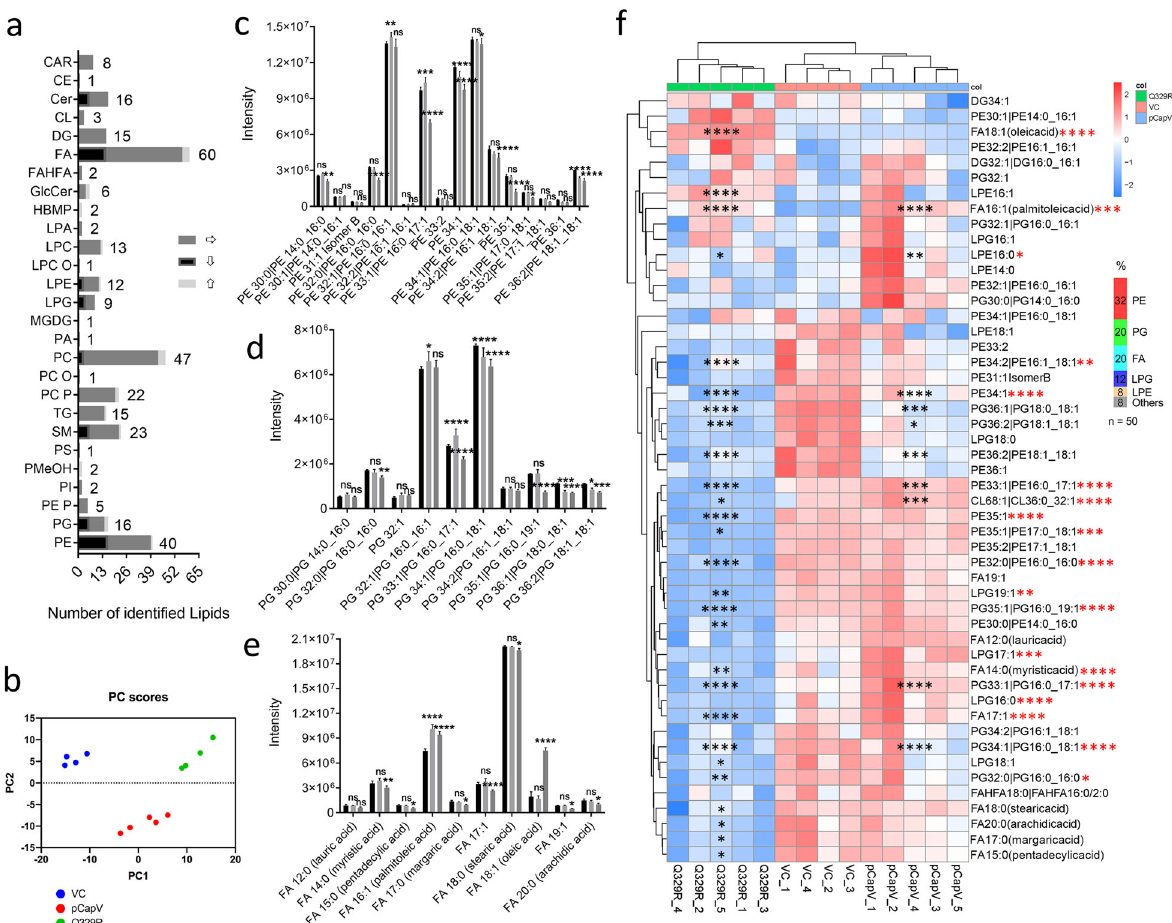
Fig. 4 CapV and CapV Q329R overexpression alter the steady-state lipid pro fi le of E. coli MG1655. a The number of identi fi ed lipid species in CapV and CapV Q329R induced fi lamentous cells compared to E. coli MG1655 vector control (VC) by untargeted charged surface hybrid column- quadrupole time-of- fl ight mass spectrometry (CSH-QTOF MS) analysis. For abbreviation of lipid compounds consult “ Methods ” . b Principle component analysis of lipid abundance upon overexpression of wild-type CapV and CapV Q329R variant proteins in E. coli MG1655 compared to VC. Of six samples each, outliers have been removed. c – e Alternation and relative abundance of PE ( c ), PG ( d ), and FA ( e ) derivatives by untargeted CSH-QTOF MS analysis. Bars represent mean values from fi ve independent replicates with error bars to represent SD. f Heatmap of selected 50 most signi fi cantly altered lipid species built based on hierarchical clustering. Each square represents one sample of each group. The color scale presenting the difference of each log 2 transformed peak intensity value to the log 2 transformed mean for each lipid species and the percentage of each lipid class is indicated on the right of the heatmap. Heatmap analysis was performed on the Tutools